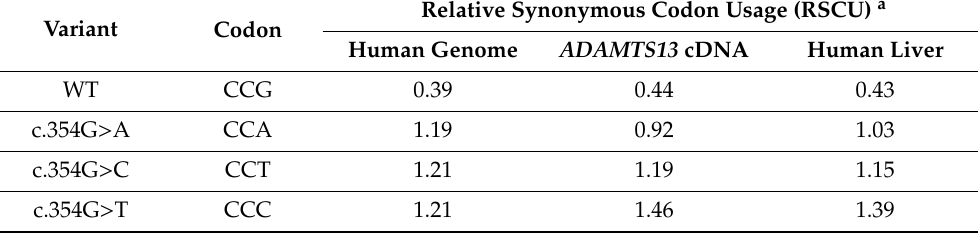
Table 1. Relative synonymous codon usage (RSCU) values of prolineencoding codons in human genome, ADAMTS13 cDNA, and liver